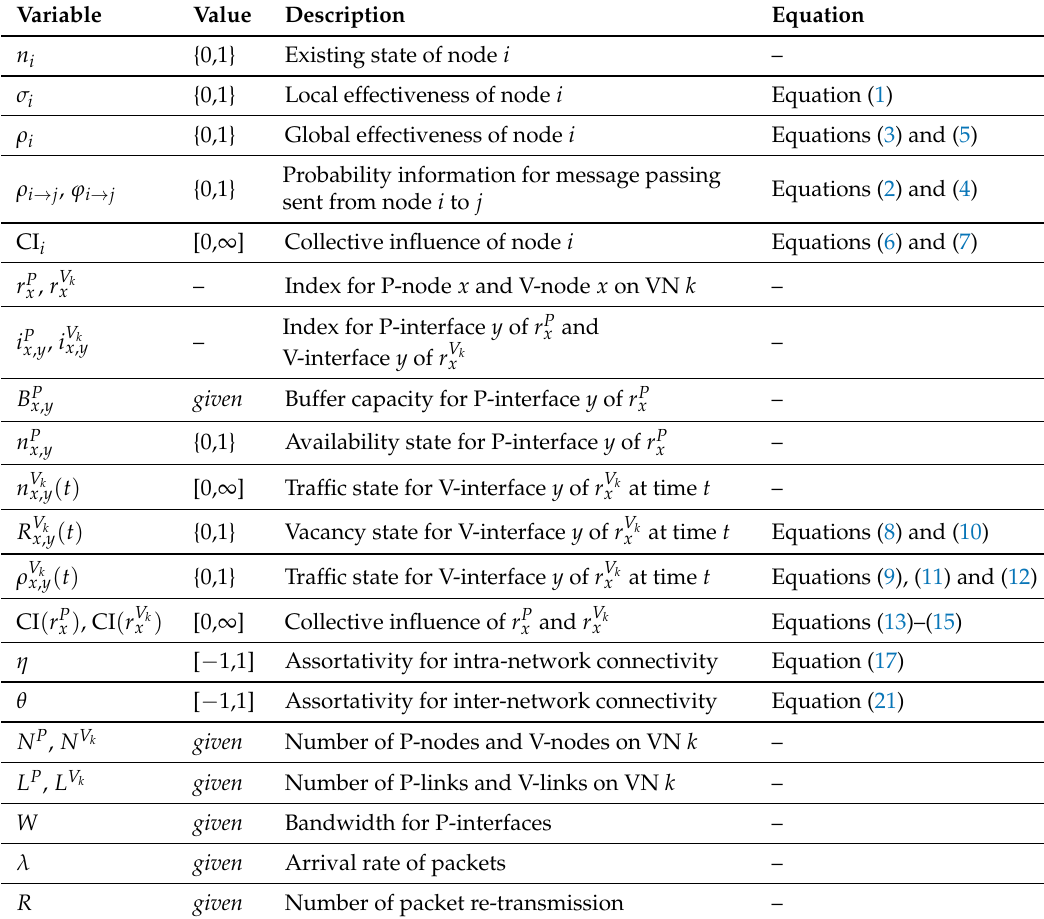
Table 2. List of variables used for the PV-NoN model and